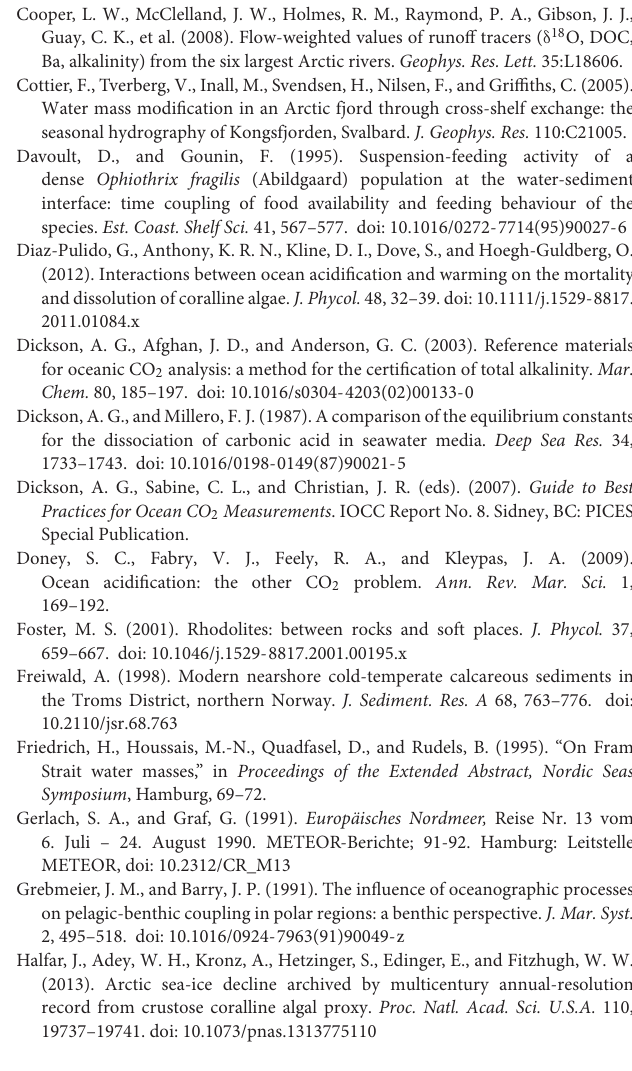
TABLE S4 | MSM55 CTD raw data for graphs in Figures 7A,C , 8 , 9 , 10E . TABLE S5 | MSM55 water sample analyses (nutrient regime, carbonate system, stable isotopes), used for Tables 2 – 4 and for graphs in Figure 10 . VIDEO S1 | Motion tracking of Mosselbukta rhodoliths (video file; mp4; uncompressed video files and the high-resolution image stack are available from the corresponding author upon